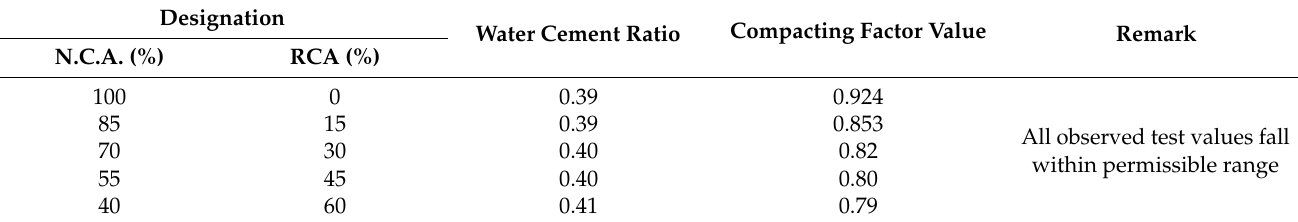
Table 4. Test results for compacting factor value.